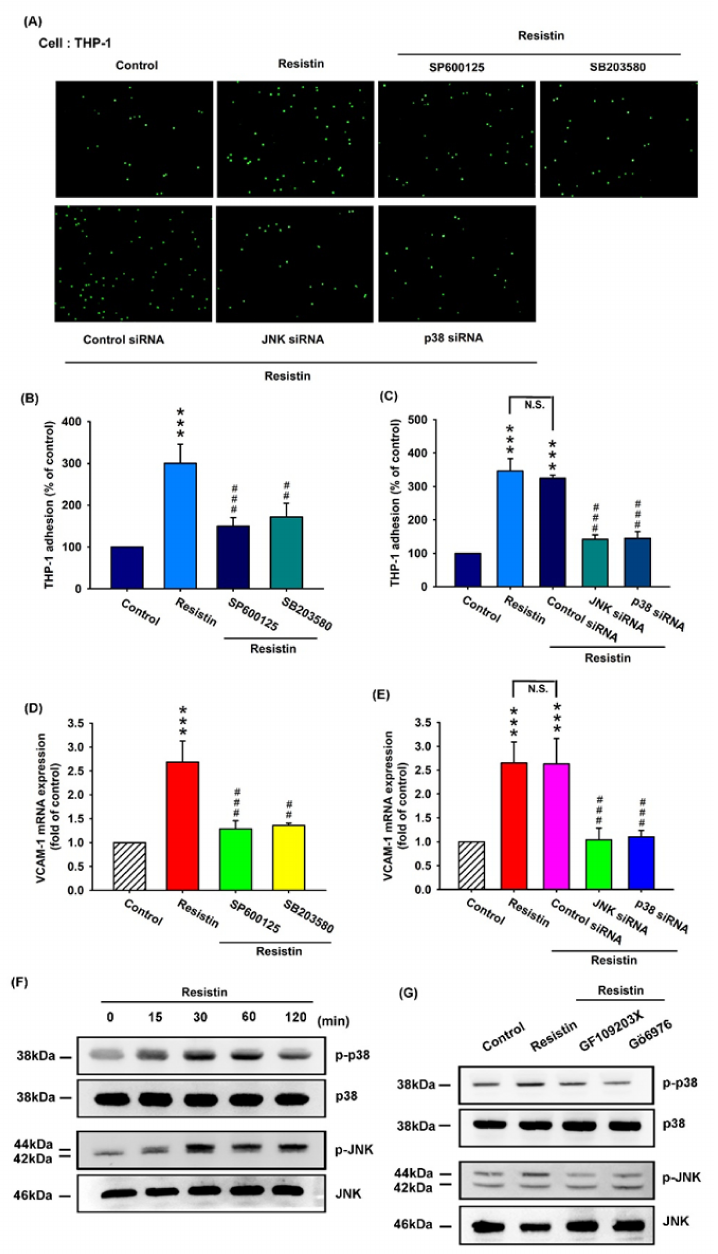
Figure 4. The p38 and JNK pathways are involved in resistin-enhanced VCAM-1 synthesis